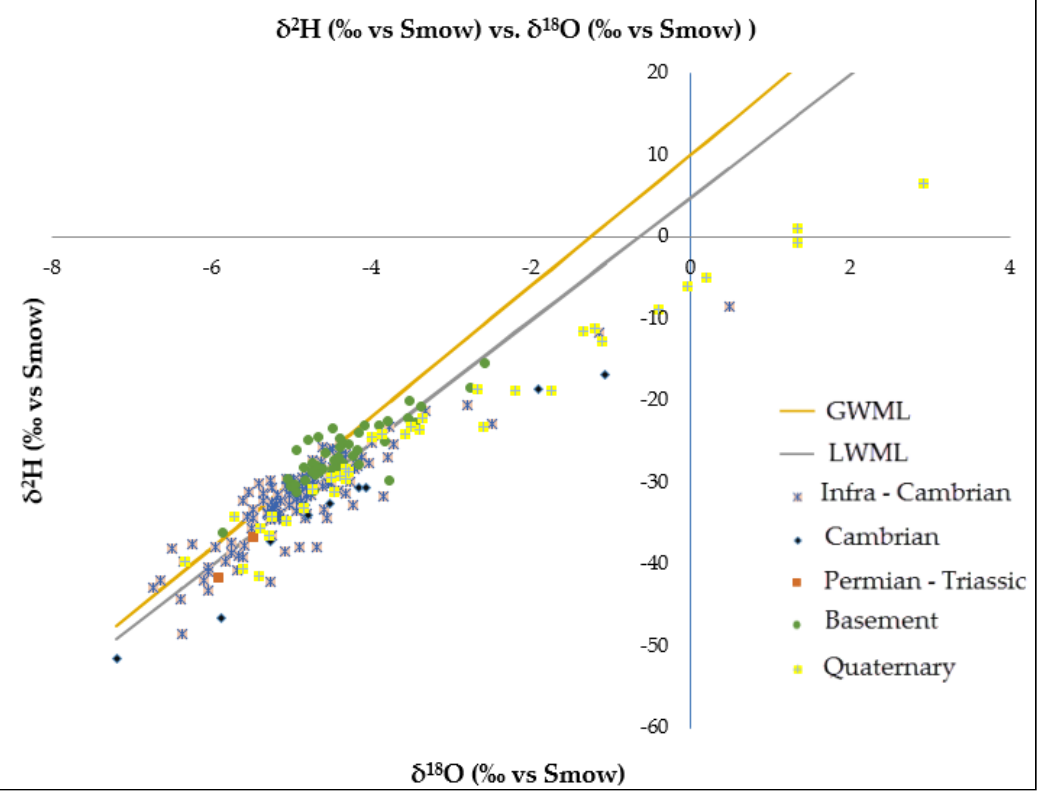
Figure 6. δ 2 H (‰ vs. Smow) vs. δ 18 O (‰ vs. Smow). Figure 6. δ 2 H (% (cid:24) vs. Smow) vs. δ 18 O (% (cid:24) vs.